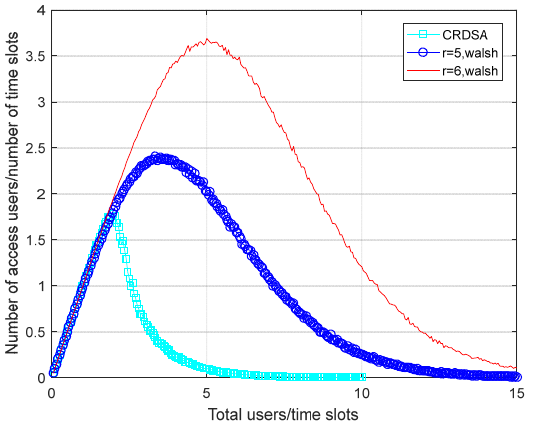
Figure 9. Throughput comparison curve under the same number of time